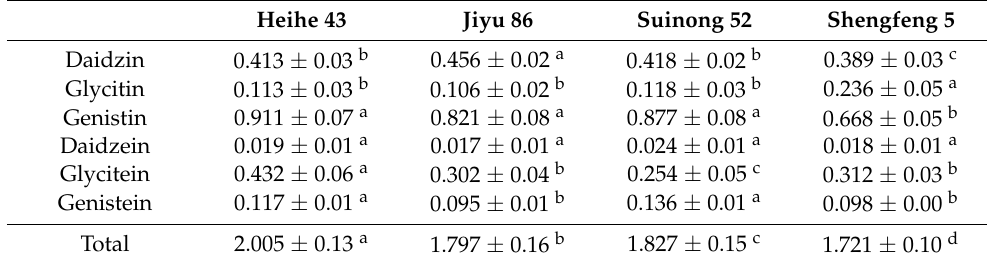
Figure 4. Composition of amino acids (%). Different lowercase letters indicate a significant differ- ence ( p < 0.05). Table 5. Composition and content of soybean isoflavones